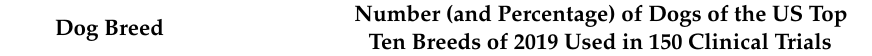
Table 4. Numbers and proportions of dogs belonging to the US top ten breeds of 2019 used in research ( n =